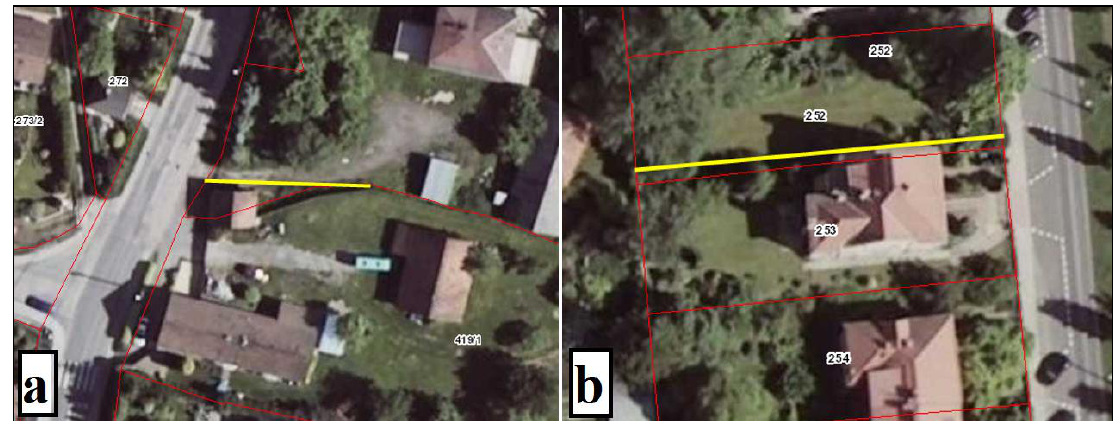
Fig. 5. Adjustment of built-up property boundary as per the actual state: a – along the fence, b – correction of a boundary intersecting a building (source: own